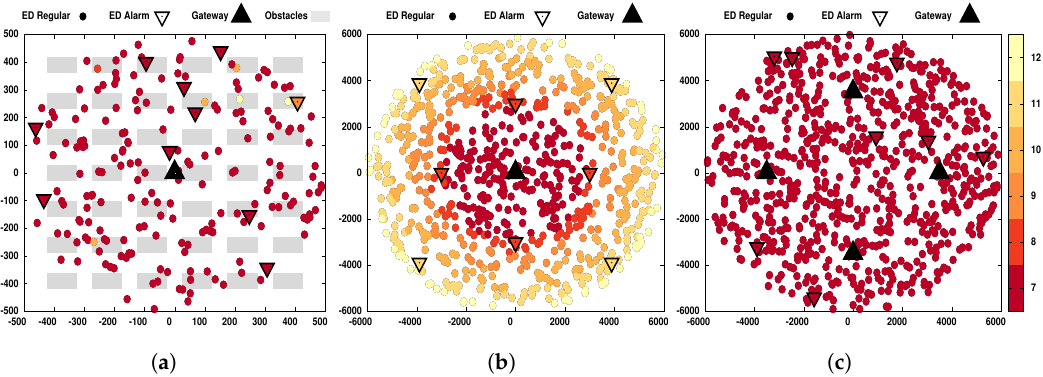
Figure 2. Sample of bidimensional spatial distribution of SF allocation for the three scenarios: ( a ) at the left-hand side, indoor with one gateway, 190 regular and 10 alarm nodes; ( b ) at the center, open field with one gateway, 792 regular and eight alarm nodes; and ( c ) at the right-hand side, open field with four gateways, 792 regular and eight alarm nodes. The marker color of each end-node (ED) changes according to the SF allocated to it. Abscissa and ordinate axes refer to distances in